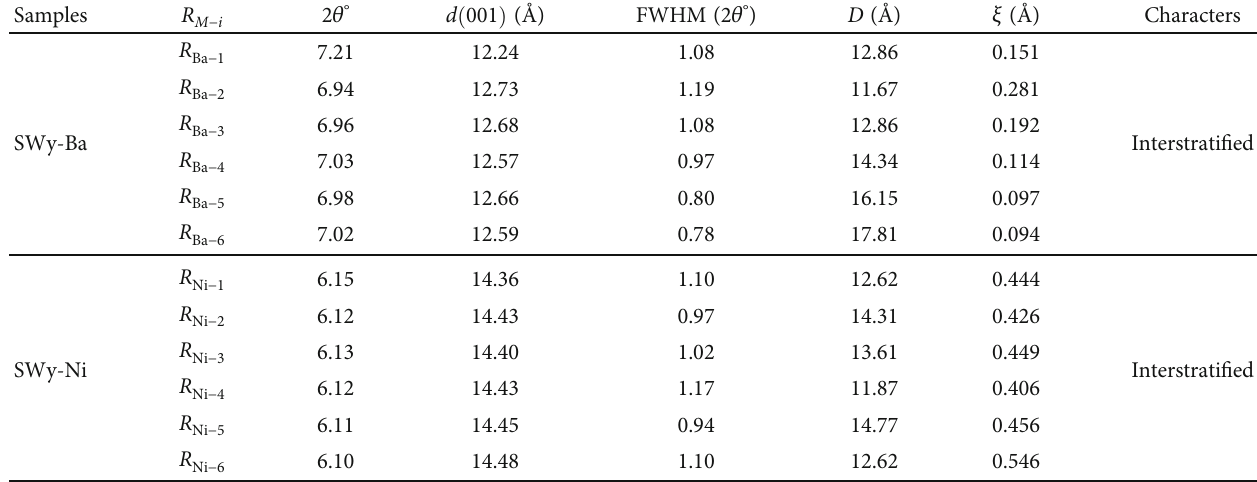
Table 5: Qualitative XRD investigation in the case of the SWy-Ba and SWy-Ni samples.